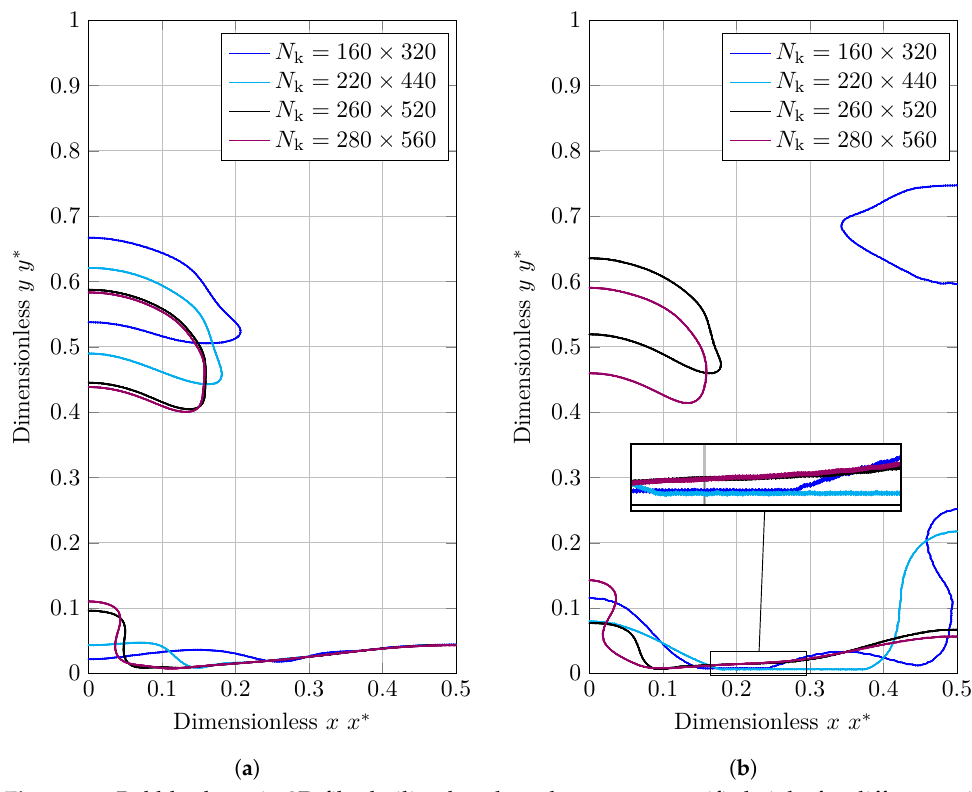
Figure 12. Bubble shape in 2D film boiling benchmark case at a specific height for different grid structures of N k = [ 160 320,220 440,260 520,280 560 ] ). ( a ) VOF; ( b ) CLSVOF. × × × × The space-averaged Nusselt number over dimensionless time is shown in Figure 13a,b. The thickness of the film has a significant impact on the Nusselt number. When the vapor layer is thin, the heat flux is larger, and when the film is thick, the heat flux is lower. As the vapor pushes to fill the bubble, the residual layer thins, increasing the average heat flux and Nusselt number; however, following detachment, the vapor returns to the superheated wall and the film thickness increases, leading to a lower Nusselt